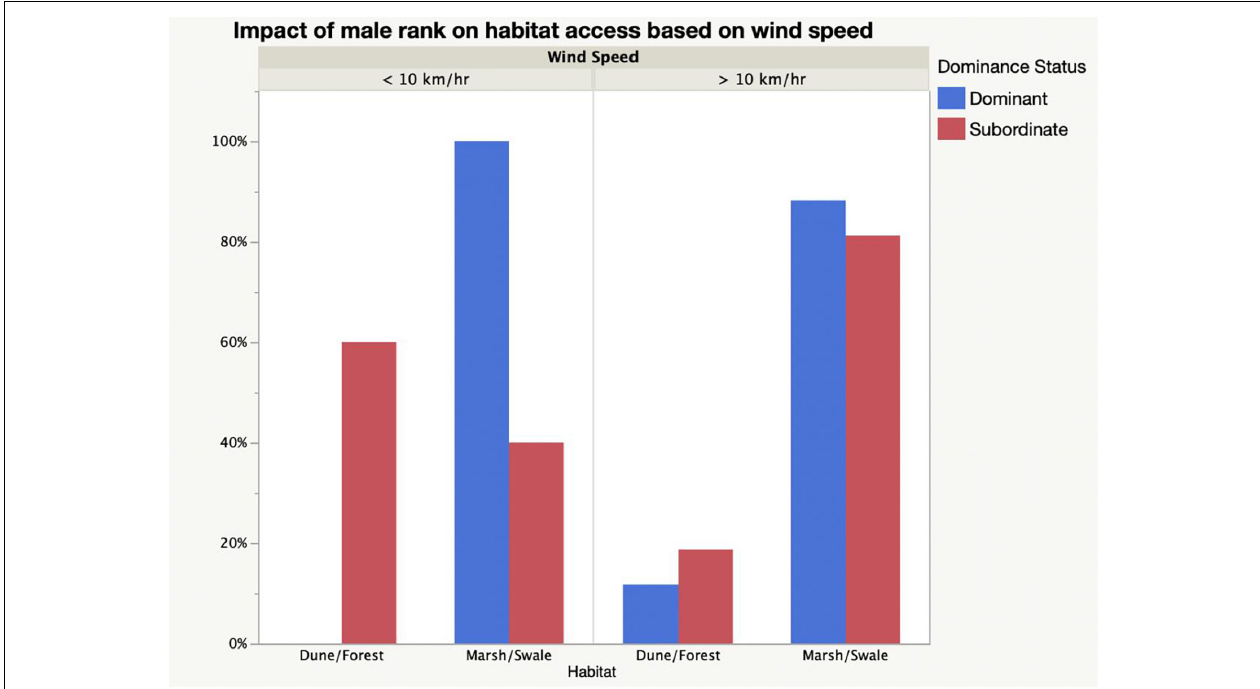
FIGURE 8 | Relationship between male dominance status and the use of relatively rare habitats (marsh and swale) and relatively abundant habitats (dune and forest) as a function of low ( < 10 km/h) and high ( > 10 km/h) wind speeds. At low wind speeds groups associated with dominant males exclusively used marsh and swale habitats (Fisher exact: p < 0.0001), but at higher wind speeds habitat access was independent of male status (Fisher exact: p = 0.5229).